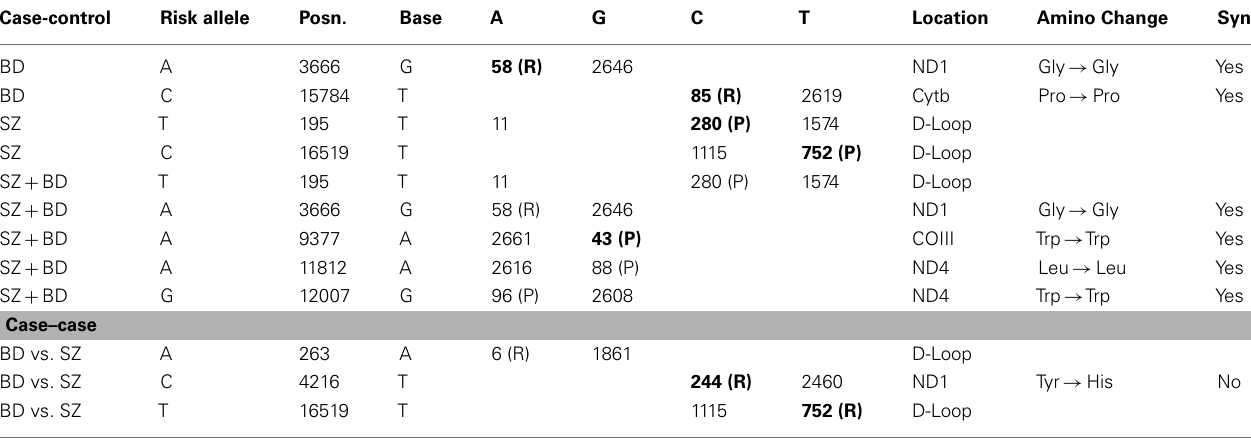
Table 4 |Annotation of nominally significant SNPs from association with pooled groups (BD + SZ), BD, and SZ are